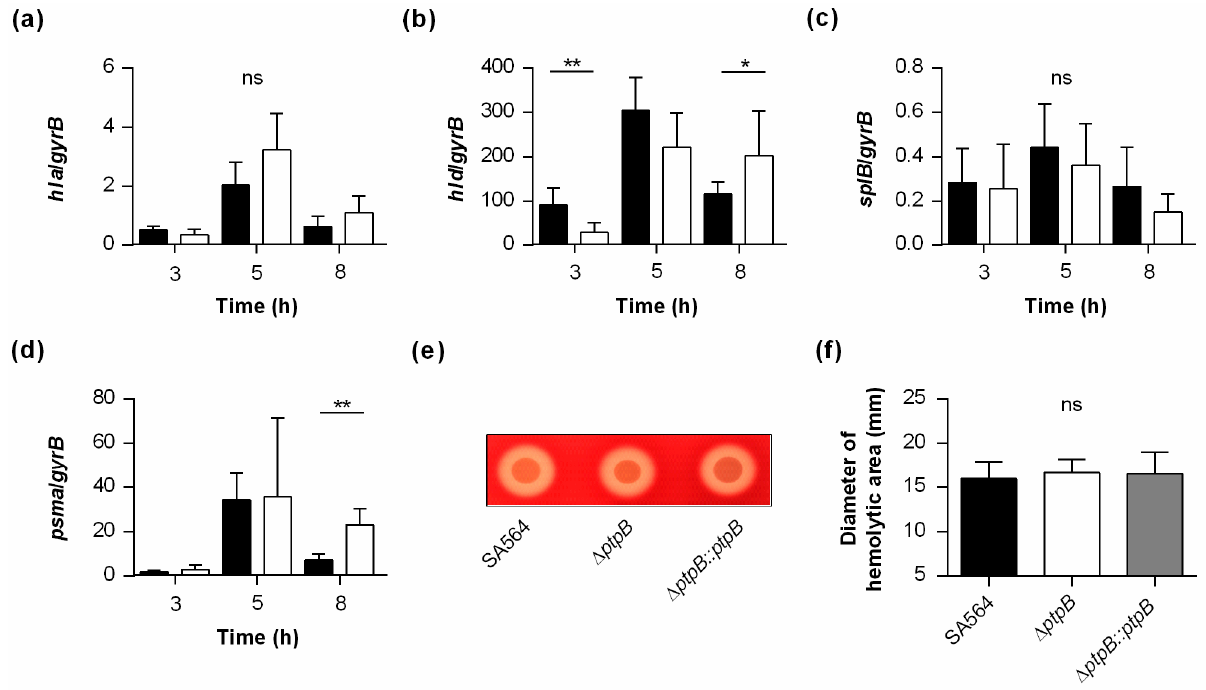
Figure 7. Effect of a ptpB deletion on the transcription of SarA- and/or AgrA-regulated genes in S. aureus SA564. ( a – d ) Quantitative transcript analyses of SarA- and/or AgrA-regulated genes by qRT-PCR in SA564 (black bars) and SA564 Δ ptpB (white bars) cells grown in TSB at 37 °C and 225 rpm to the time points indicated. Growth phase-dependent transcript rates of Sar box containing genes hla ( a ), hld ( b ), and splB ( c ), and of the AgrA-driven psma cluster ( d ). Transcript rates were quantified in reference to the transcription of gyrase B (in copies per copy of gyrB ). Data are presented as mean + SD of five biological replicates. * p < 0.05; ** p < 0.01; ns, not significant (Mann–Whitney-U test between wild-type and mutant at a given time point). ( e , f ) Overnight cultures of S. aureus strain SA564 (black bar), its isogenic Δ ptpB mutant (white bar), and the cis -complemented SA564 Δ ptpB::ptpB derivative (gray bar) were normalized with fresh TSB medium to an OD 600 of 12, and 5 µL of the suspensions spotted on sheep blood agar plates. Inoculated plates were cultured for 24 h at 37 °C, and hemolytic areas were determined. ( e ) Representative image of one experiment. ( f ) Diameter of hemolytic areas. The data presented are the mean + SD of three biological experiments done in duplicate. ns, not significant (Kruskal–Wallis test followed by Dunn’s post hoc test).